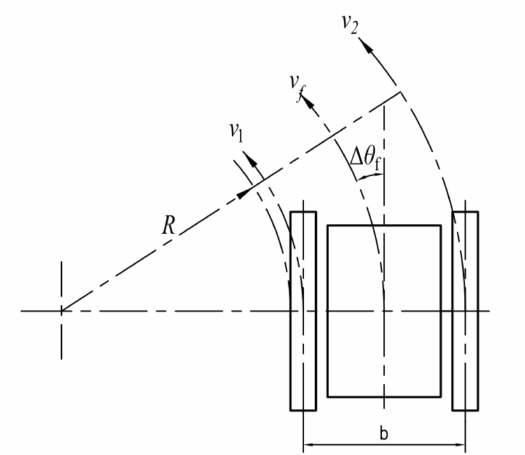
Figure 25. The illustration of the robot motion parameters. In the figure, R represents the radius of the robot when turning, ∆ θ f represents the deflection angle relative to the current traveling direction, v 1 and v 2 represent the speed of the left and right traveling subassemblies, v f represents the speed of the robot and b represents the distance between the left and right